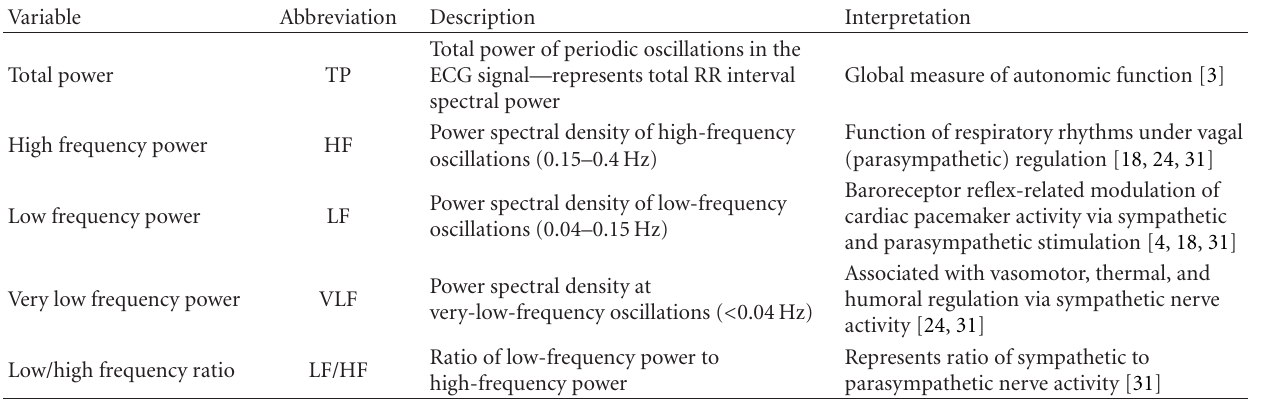
Table 2: Definitions of frequency-domain metrics of heart rate